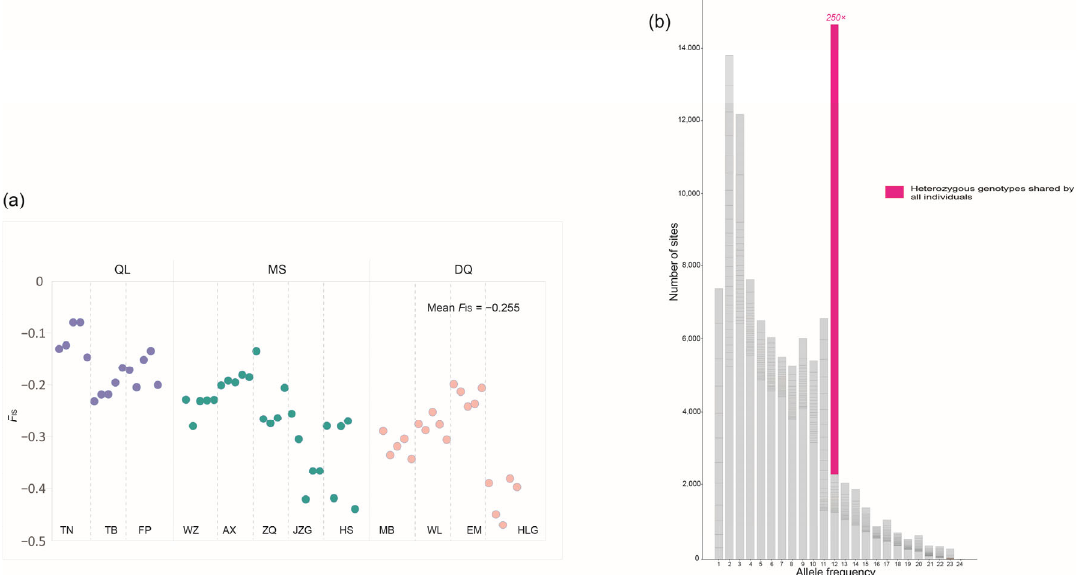
Figure 2. Analyses of individual heterozygosity in K. uniflora . ( a ) Distribution of values of inbreeding coefficient ( F IS ). Under Hardy–Weinberg equilibrium F IS is 0, negative values of F IS indicate excess of individual heterozygosity. ( b ) The site frequency spectrum (SFS) depicting the number of sites with different allele frequency across 12 K. uniflora individuals (one allele can display a maximum frequency of 24 among 12 diploid individuals). Heterozygous genotypes shared among all 12 populations are highlighted using the purple color and its excess over HWE indicated ( c . 250 times as frequent as expected under